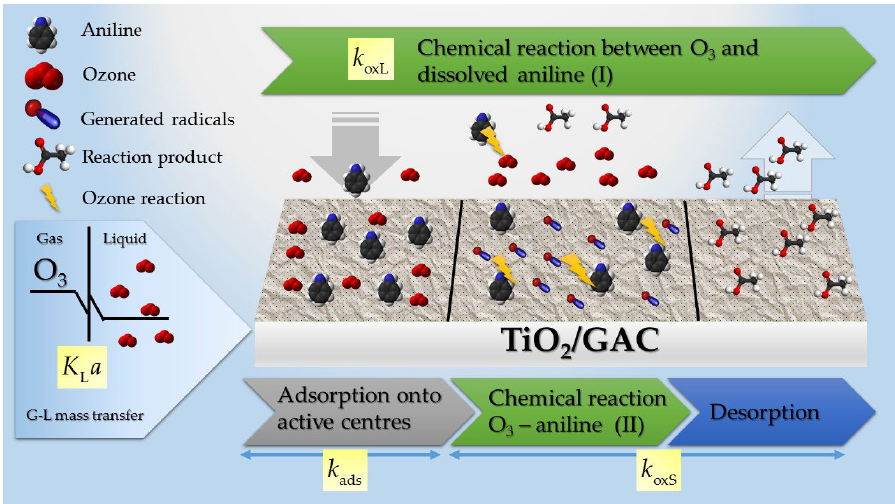
Figure 9. A three-phase modelling for TiO 2 /GAC catalytic ozonation of aniline-contaminated water. Reproduced with permission from Ref. [132].